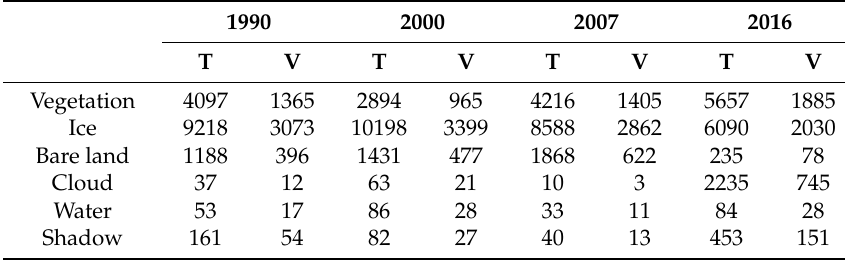
Table 2. Number of training and verification points for six land cover types in 1990, 2000, 2007 and 2016 (“T” for training points and “V” for validation